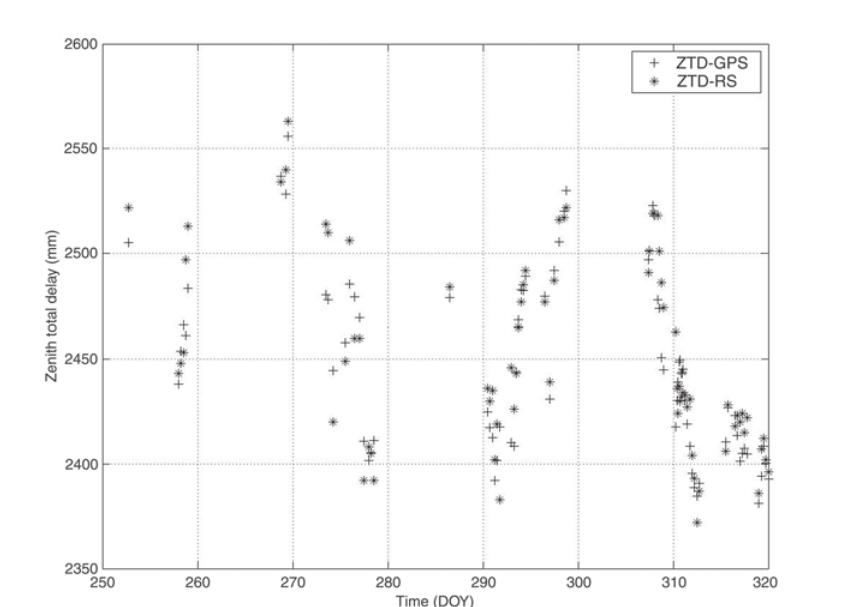
Fig. 1. ZTD by GPS for Padua and ZTD by radiosounding for Verona (mm) versus time for MAP-SOP